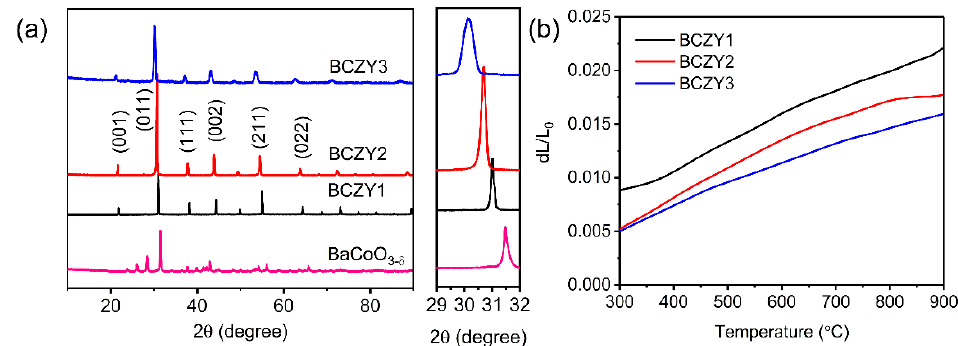
Figure 1. ( a ) RT-XRD patterns and ( b ) Thermal expansion curves of various BCZY samples.